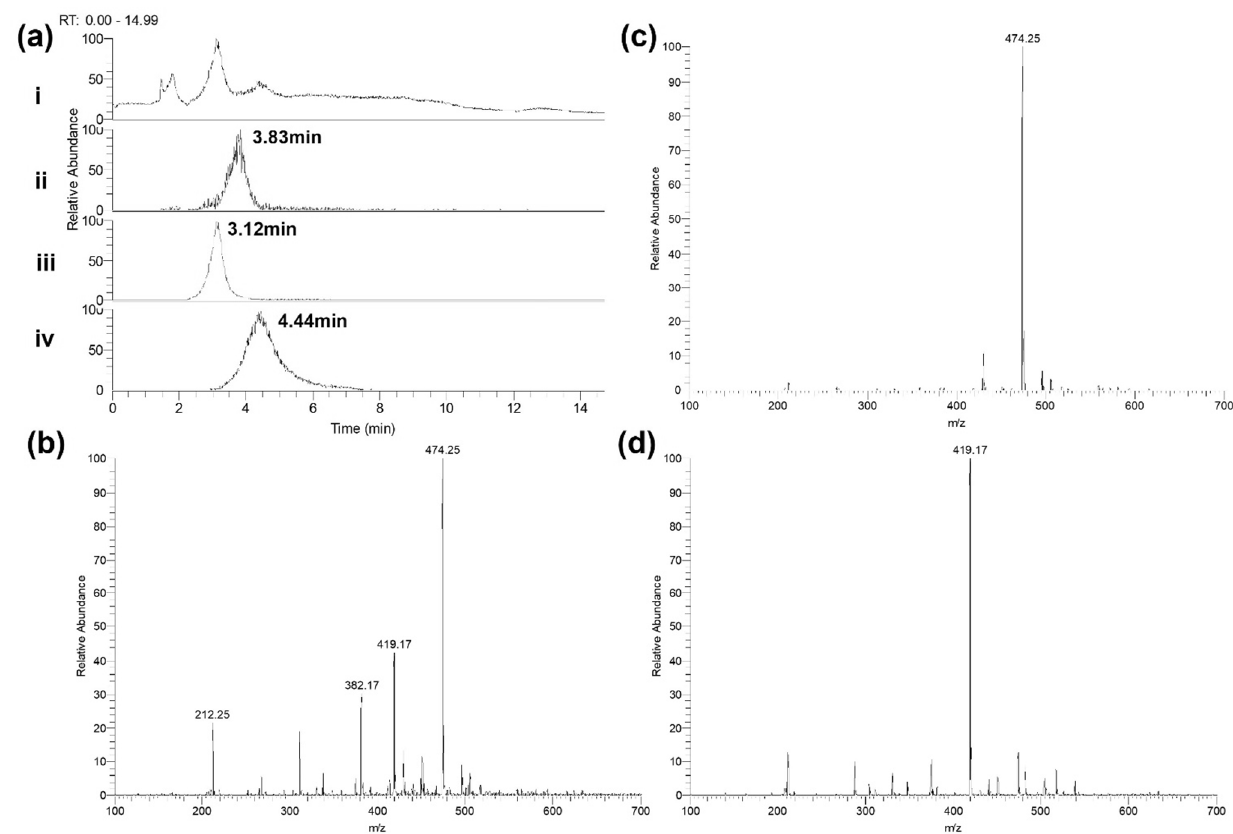
Figure 6. Detection of carbapenems by LC-MS. ( a ) Chromatograms of meropenem, ertapenem and doripenem solutions at 10 mg/L in PBS—(i) total ion chromatogram (TIC); (ii) extracted ion chro- matogram (XIC) of meropenem—expected mass 381.5–383.0 m/z; (iii) XIC of ertapenem—expected mass 473.5–475.0 m/z; (iv) XIC of doripenem—expected mass 418.5–420.0 m/z. ( b ) Meropenem —spectrum of elution at 3.83 min. Expected mass of 382.2 m/z. ( c ) Ertapenem—spectrum of elution at 3.12 min. Expected mass of 474.2 m/z. ( d ) Doripenem—spectrum of elution at 4.44 min. Expected mass of 419.2 m/z. Representative data of repeat experiments is